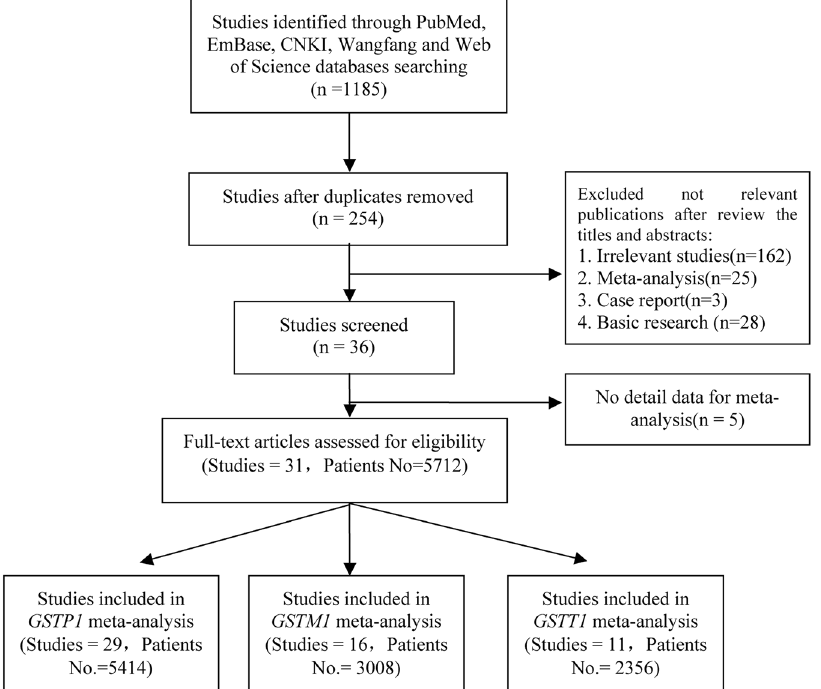
Figure 1. Procedure of article